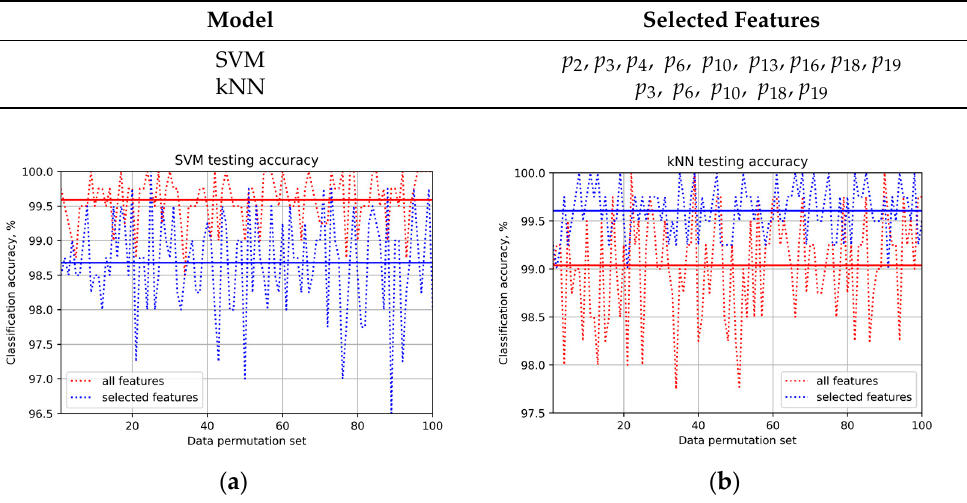
Table 4. Most important features according to SHAP analysis.